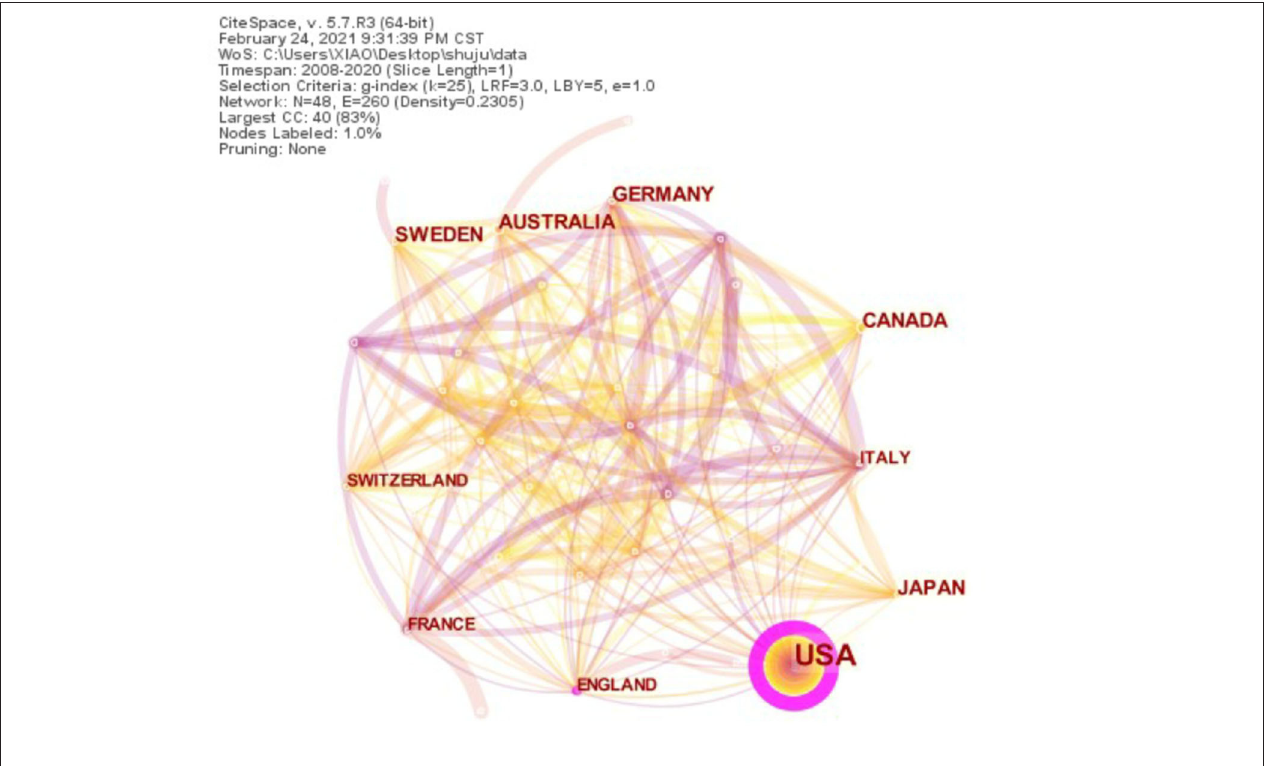
FIGURE 2 | Top 10 collaboration network of country on BPD in extremely pre-mature infants.